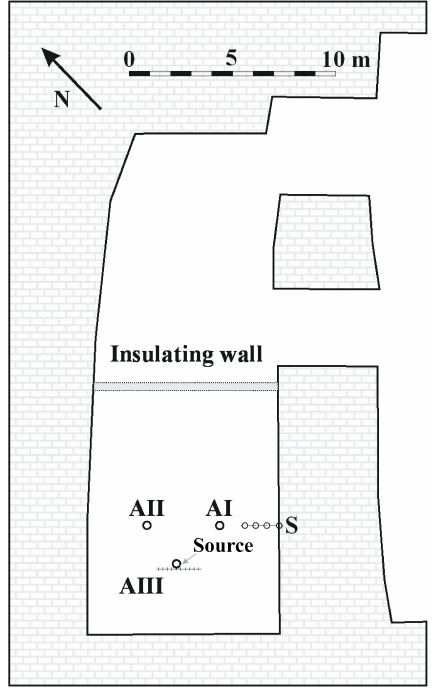
Figure 1. Sketch of the experiment room S15 in the Vincennes quarry showing the location of temperature setups AI, AII, AIII, and S, and of the insulating wall installed in July